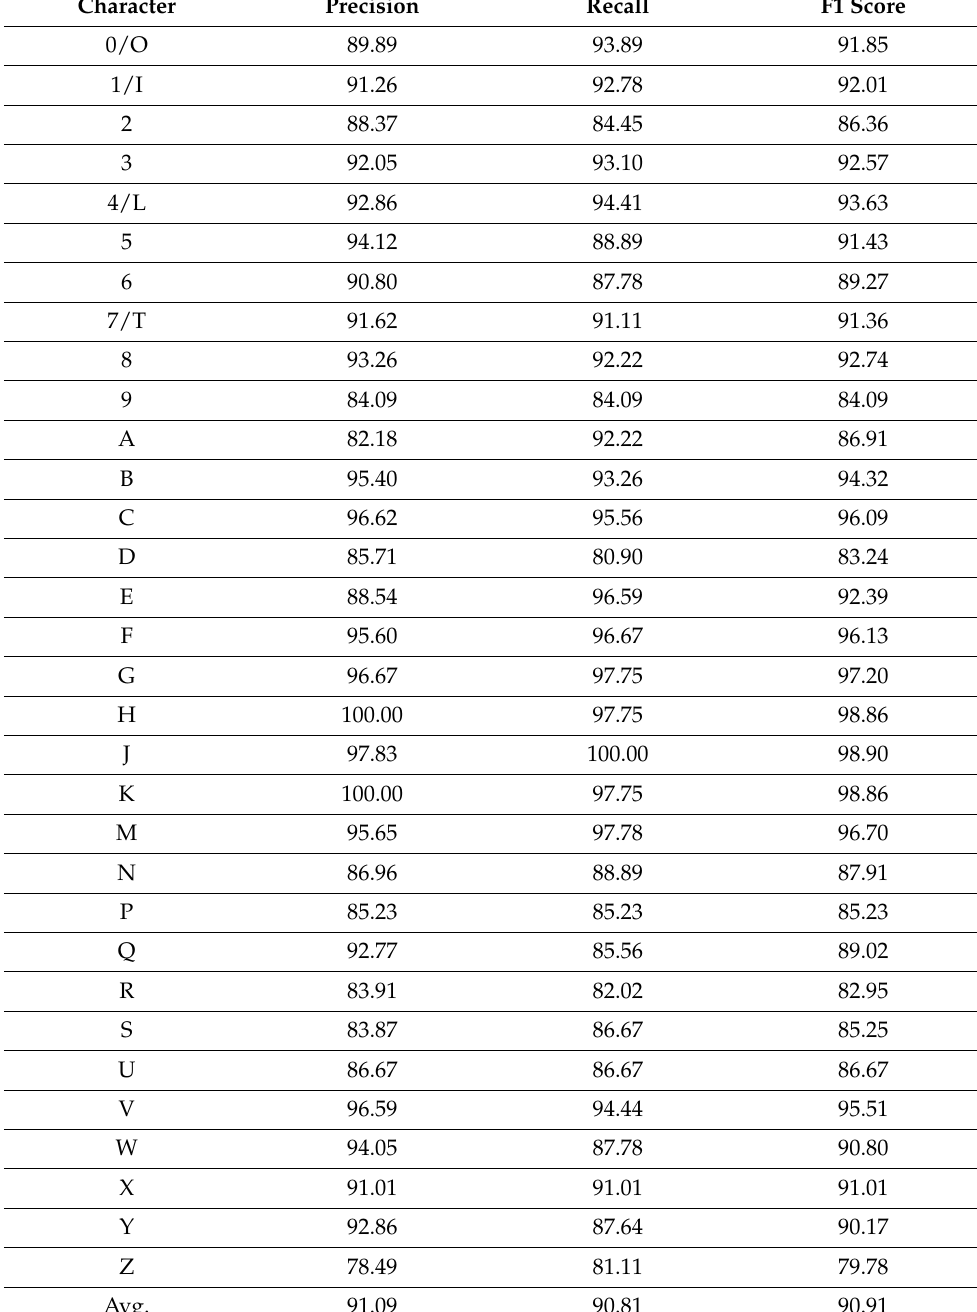
Table 3. Accuracies according to the characters.